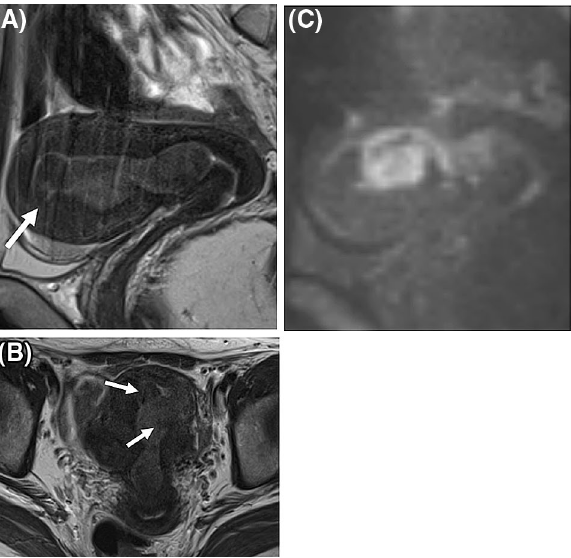
Figure 3. A false-negative case of low-grade endometrial stromal sarcoma. Tumor predominantly located in endometrial cavity with a small portion of myometrial invasion ( A , arrow) on T2-weighted images. There might be intra-tumoral low signal intensity (SI) bands on T2-weighted images ( B , arrows), but unclear. The tumor showed high SI on diffusion-weighted images ( C ) with low apparent diffusion coefficient